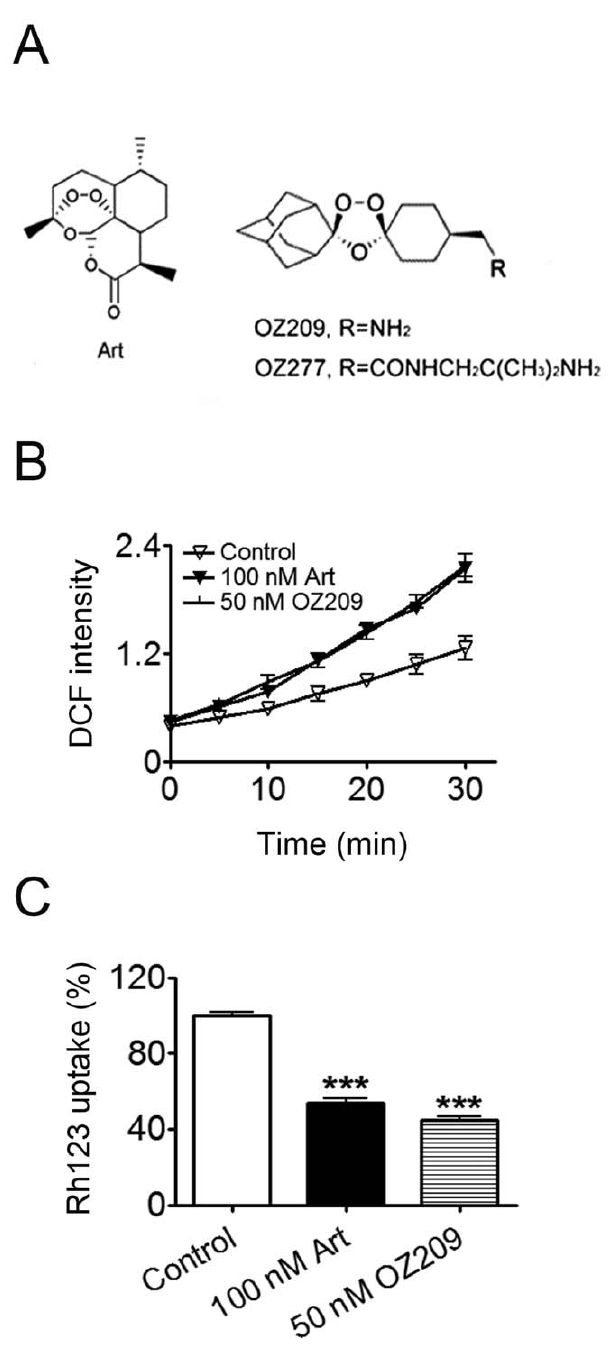
Figure 6. OZ209, a synthetic endoperoxide antimalarial with structurally different backbone, also affects the malarial mitochondrial functions. (A) Molecular structures of artemisinin, OZ209 and OZ277. (B) OZ209 and its effect on the ROS production in isolated malarial mitochondria. ROS production in isolated P. berghei mitochondria was monitored by measuring DCF fluorescence intensity. (C) OZ209 and its depolarizing effect on mitochondrial membrane. Dy of isolated P. berghei mitochondria was assessed by measuring the Dy - dependent uptake of Rh123. n=3. Data were shown as mean 6 SEM. *** p , 0.0001 versus